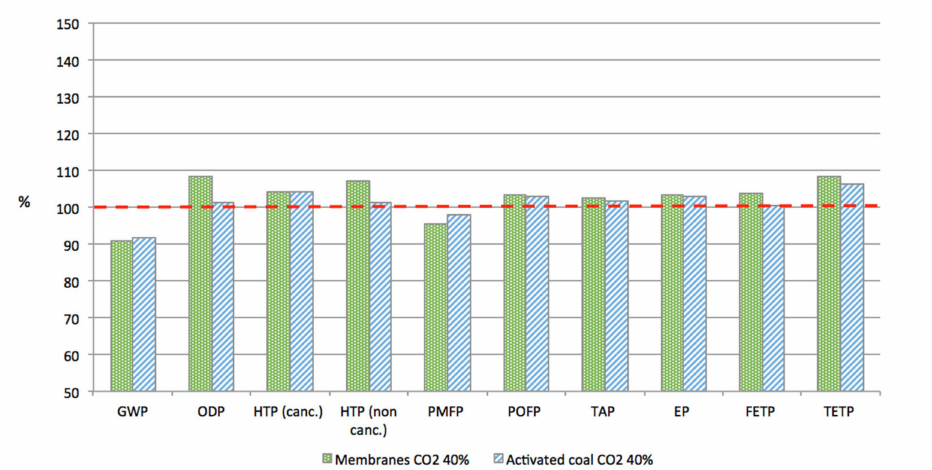
Figure 5. Comparison of the alternative scenarios with the reference case (set to 100%), CO 2 at 40%. Impacts: global warming potential (GWP100), eutrophication potential (EP), freshwater eu- trophication (FEP), terrestrial acidification (TAP), particulate matter formation potential (PMFP), photochemical oxidant formation potential (POFP), ozone depletion potential (ODP), human